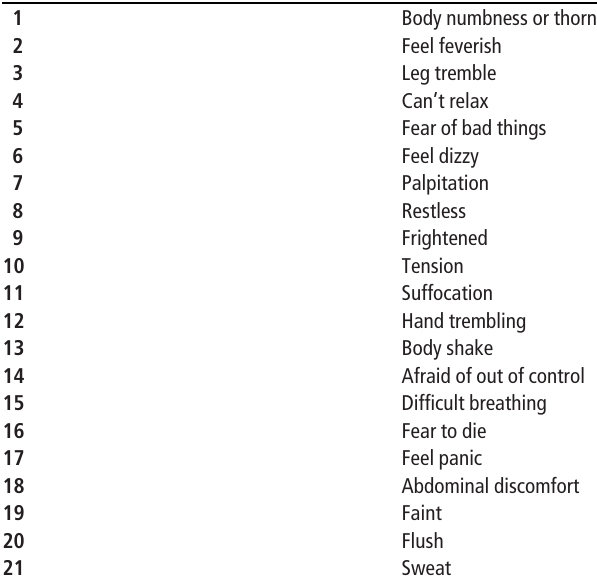
Table III Beck anxiety inventory (BAI)